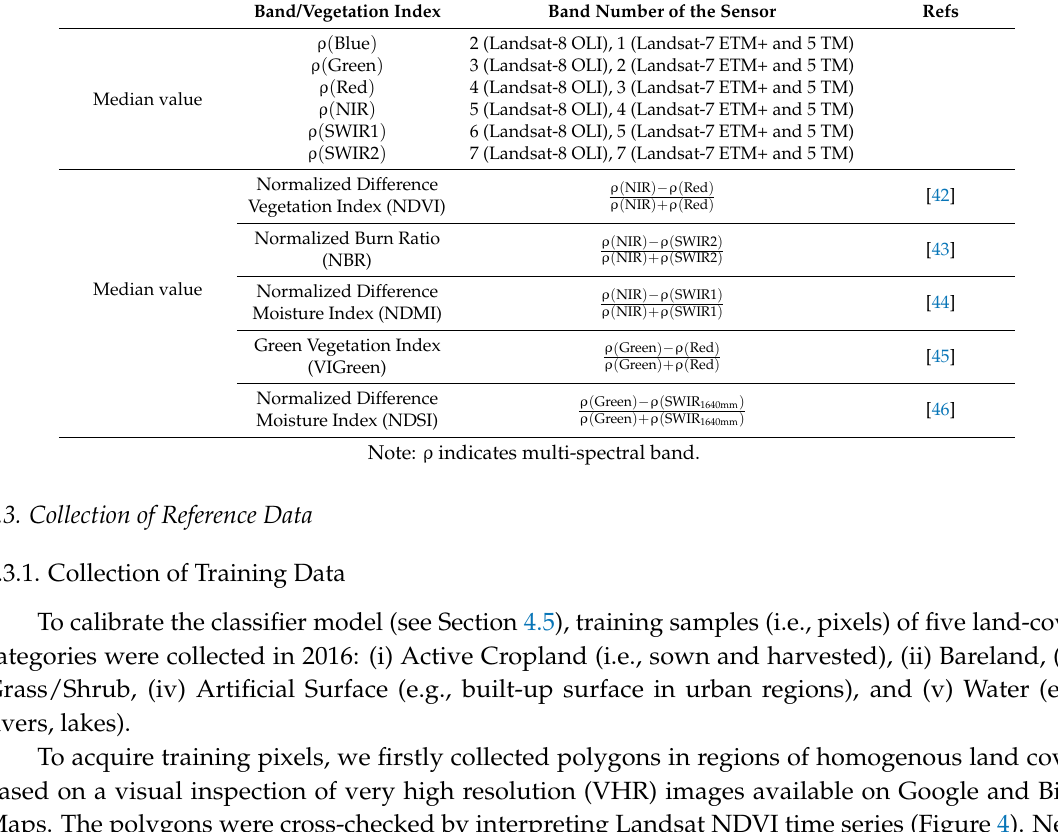
Figure 3. Data availability of each study region. Note: This figure shows the data availability in the seven study regions of this study. After monthly image composition, we acquired the monthly maximum normalized difference vegetation index (NDVI) time series between April and October for each year. Therefore, for each study region, we acquired seven images (one for each month). For each pixel of an image, for example, the April image of BL in 2016, if no cloud-free period is recorded during this month, the pixel was labelled “non value” in the composited 2016 April image. Then we used the number of 50% monthly composited cloud-free periods for each study region/year to represent the data availability in this figure. For example, the 2016 images in BL show that more than 50% cloud-free pixels were acquired in all seven monthly composited images, while for the 2003 images in LT, we acquired only two monthly composited images with more than 50% cloud-free pixels. Table 2. Features extracted from the Landsat images.